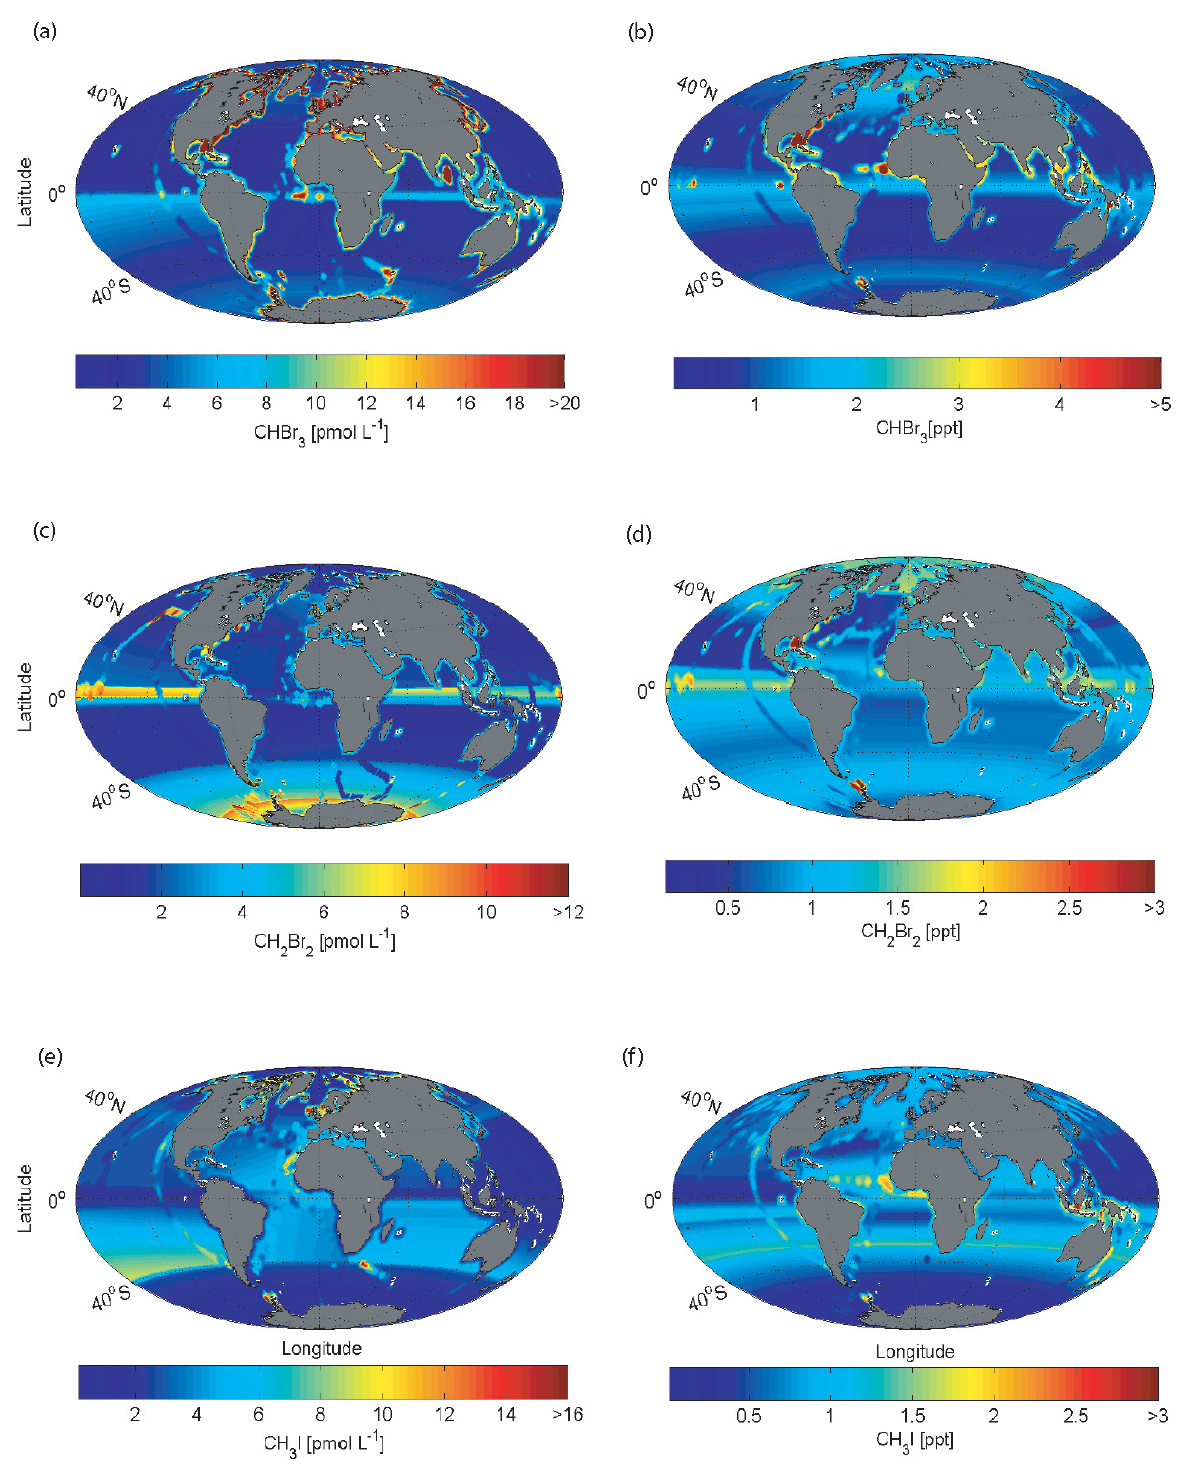
Fig. 4. Global maps of marine concentrations (pmolL − 1 ) and atmospheric mixing ratios (ppt) for bromoform (a, b) , dibromomethane (c, d) and methyl iodide (e, f) based on the robust fit (RF) regression analyses. The concentration maps calculated with the OLS method are included in the Supplement (Fig.